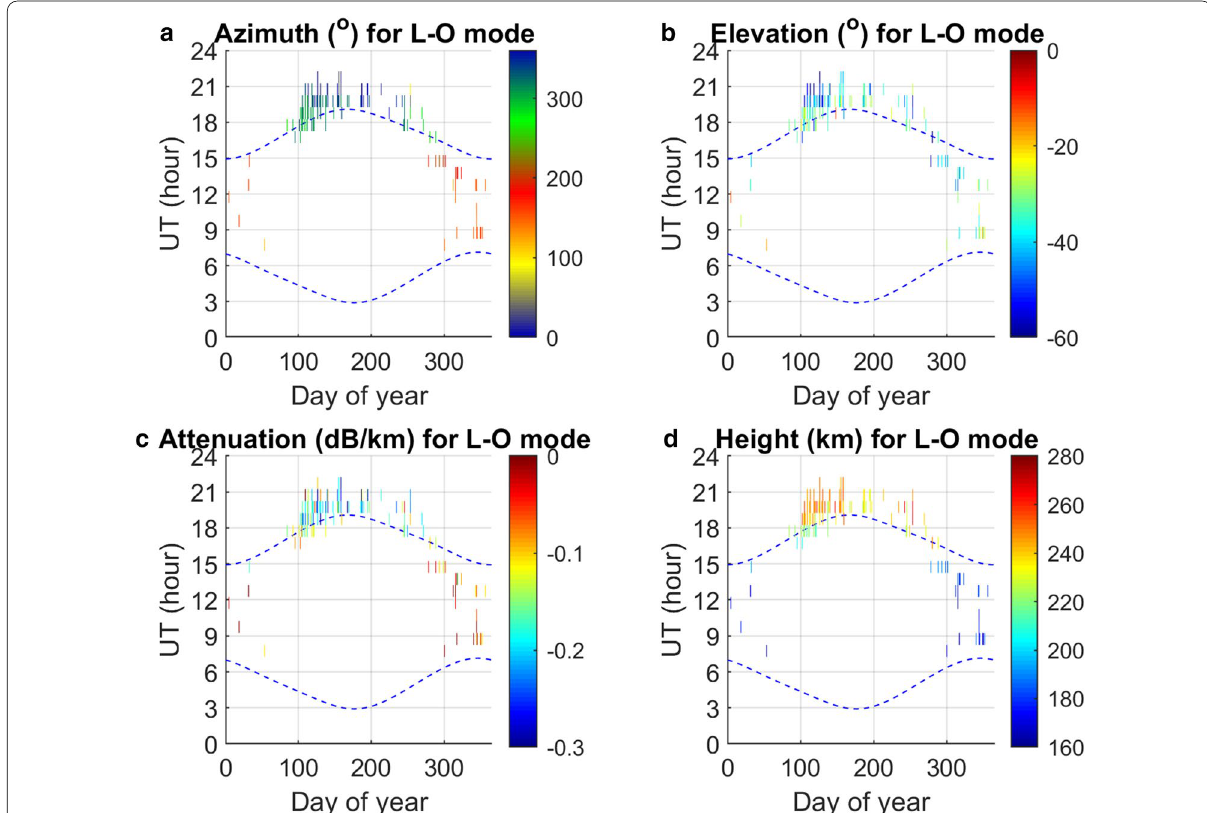
Fig. 9 Azimuth, elevation ǫ , attenuation A dBkm and height of observation for the period September 2018–August 2019 (solar minimum) and L-O mode. The values are color-coded. Dashed lines indicate times of sunrise and